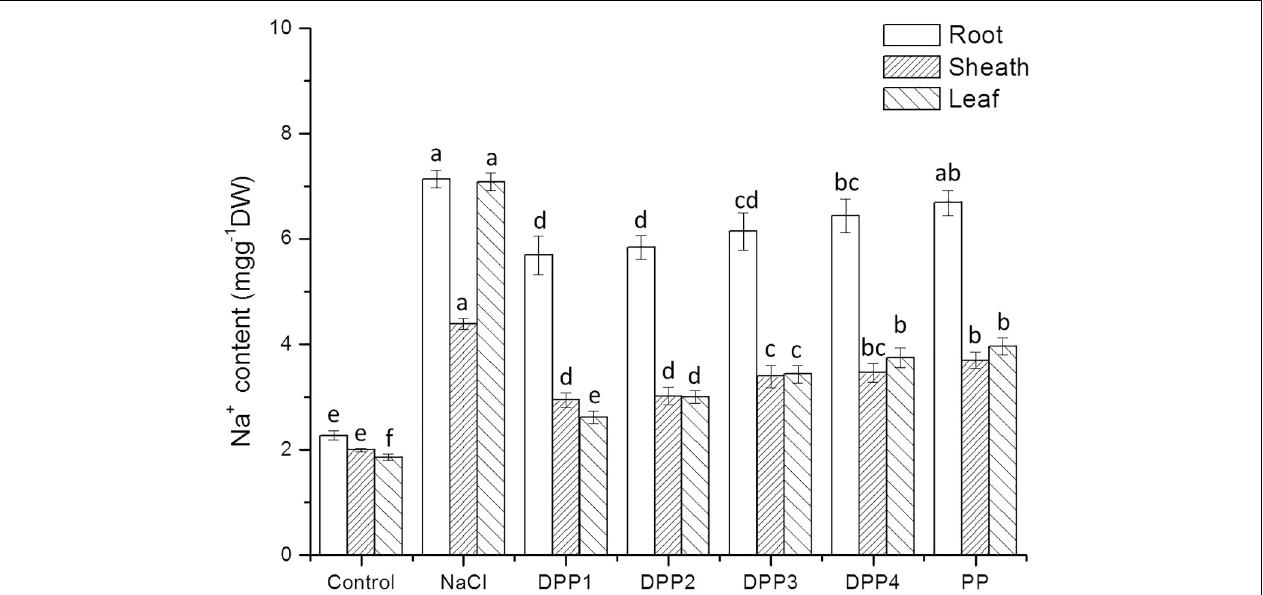
FIGURE 6 | Effect of four degraded (DPP1,2,3,4) and natural polysaccharides (PP) from P. yezoensis on Na + contents of root, sheath, and leaf in wheat seedlings. Values are the mean ± SD of three replicates. Different letters indicate significant differences at P < 0.05.